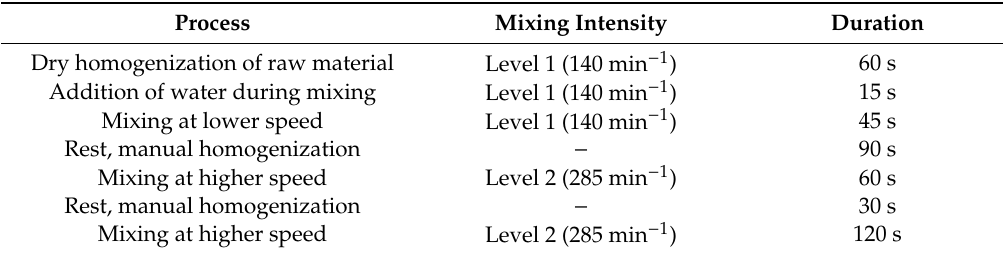
Table 1. Mixing procedure to prepare cement